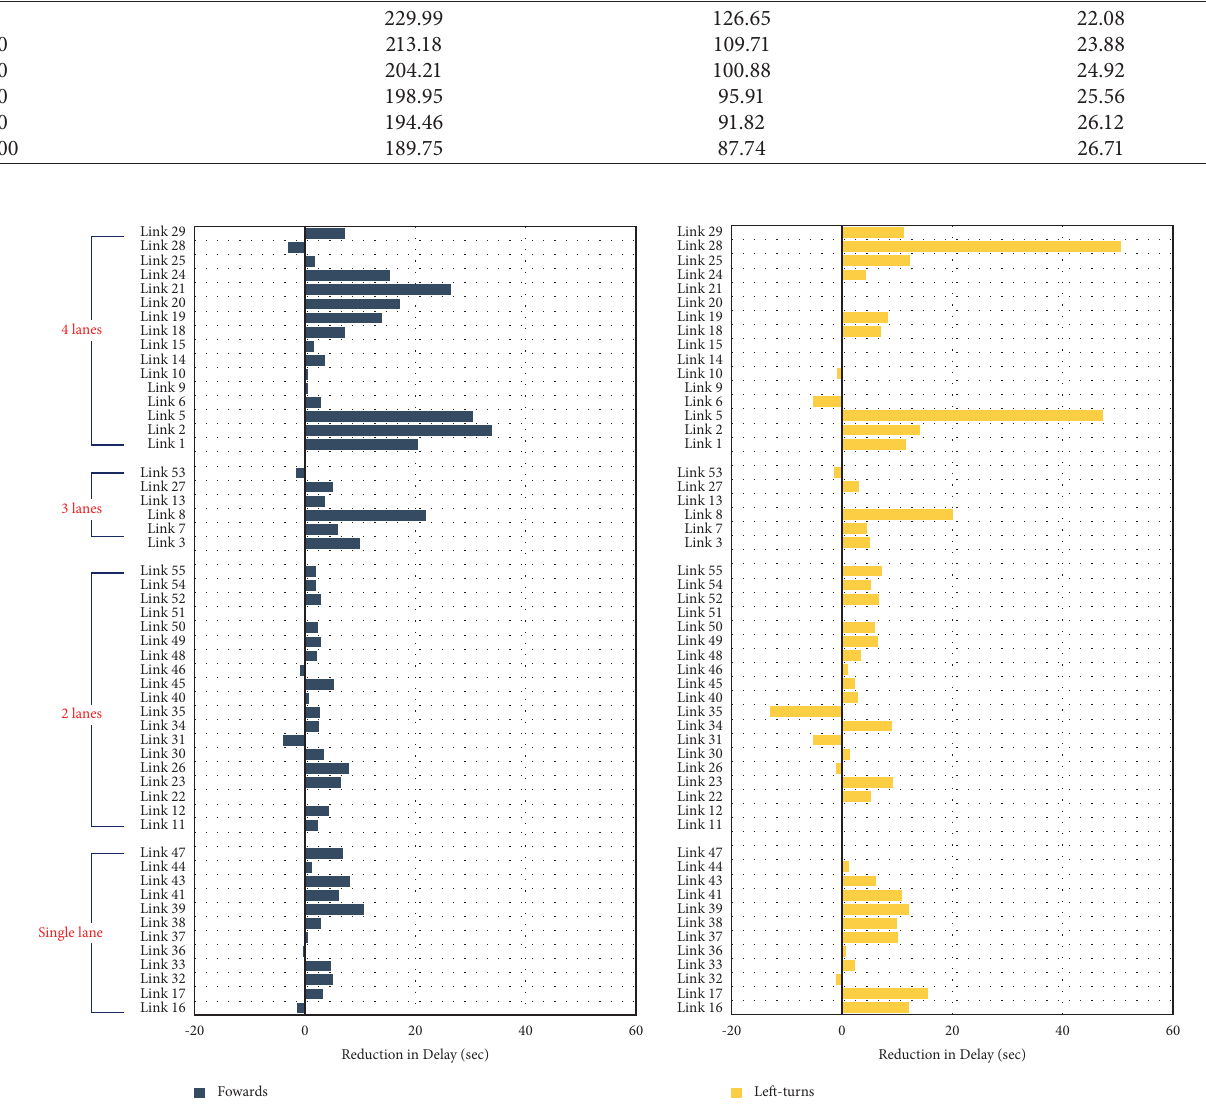
Figure 4: Reduction in delays of the links by lane numbers at 100% penetration rate.